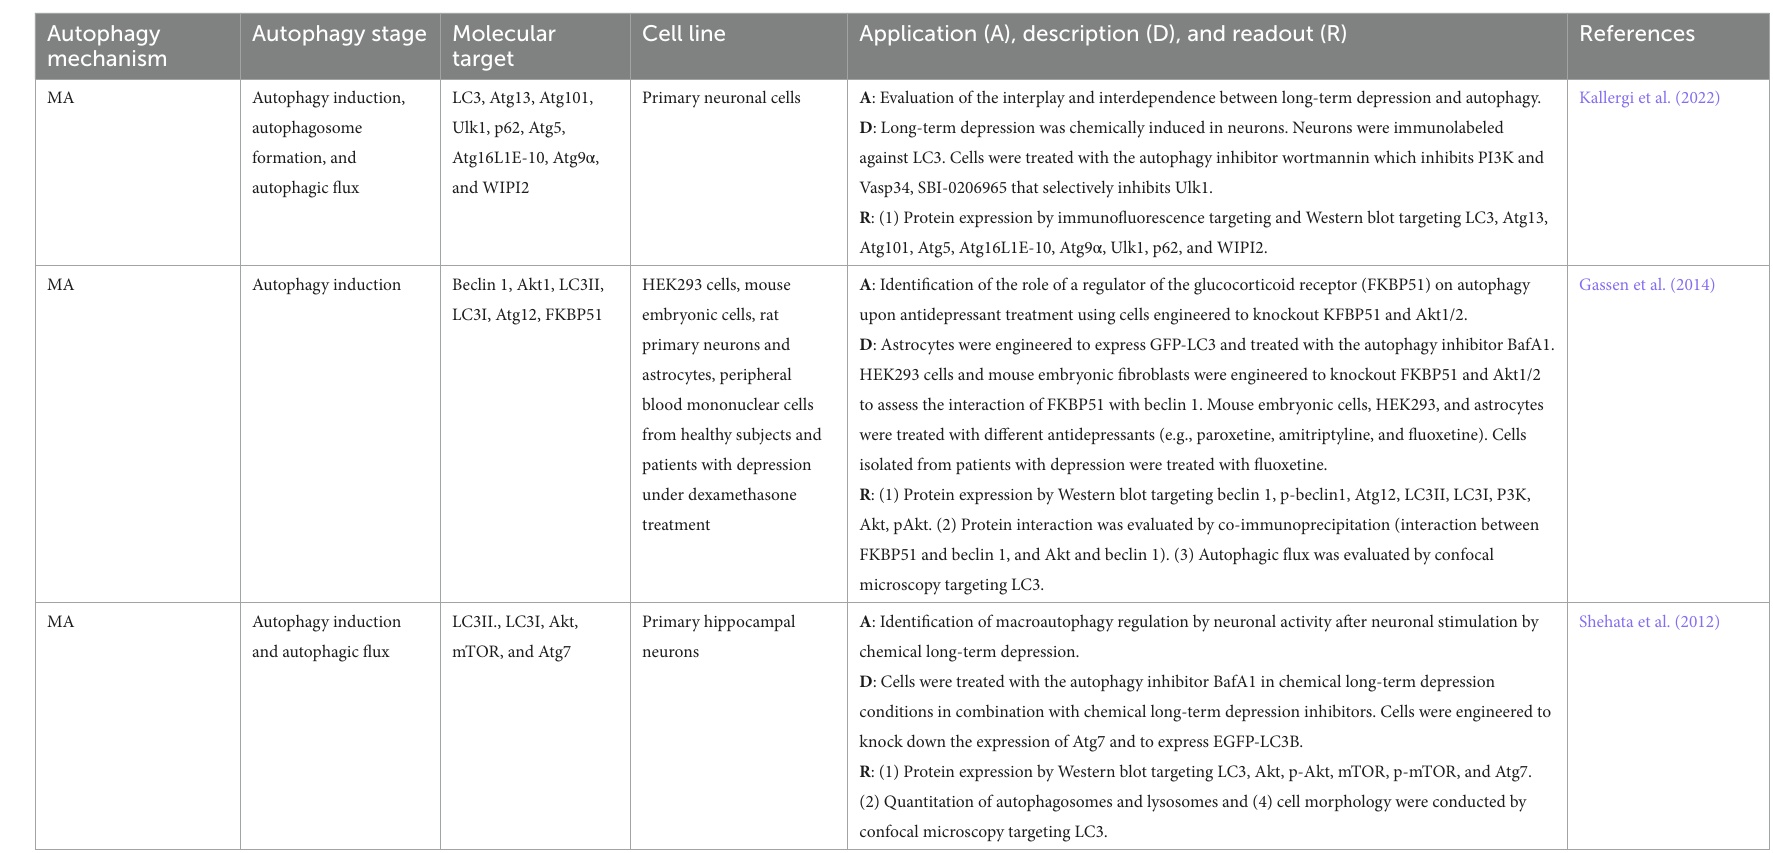
TABLE 5 In vitro autophagy methods in depression